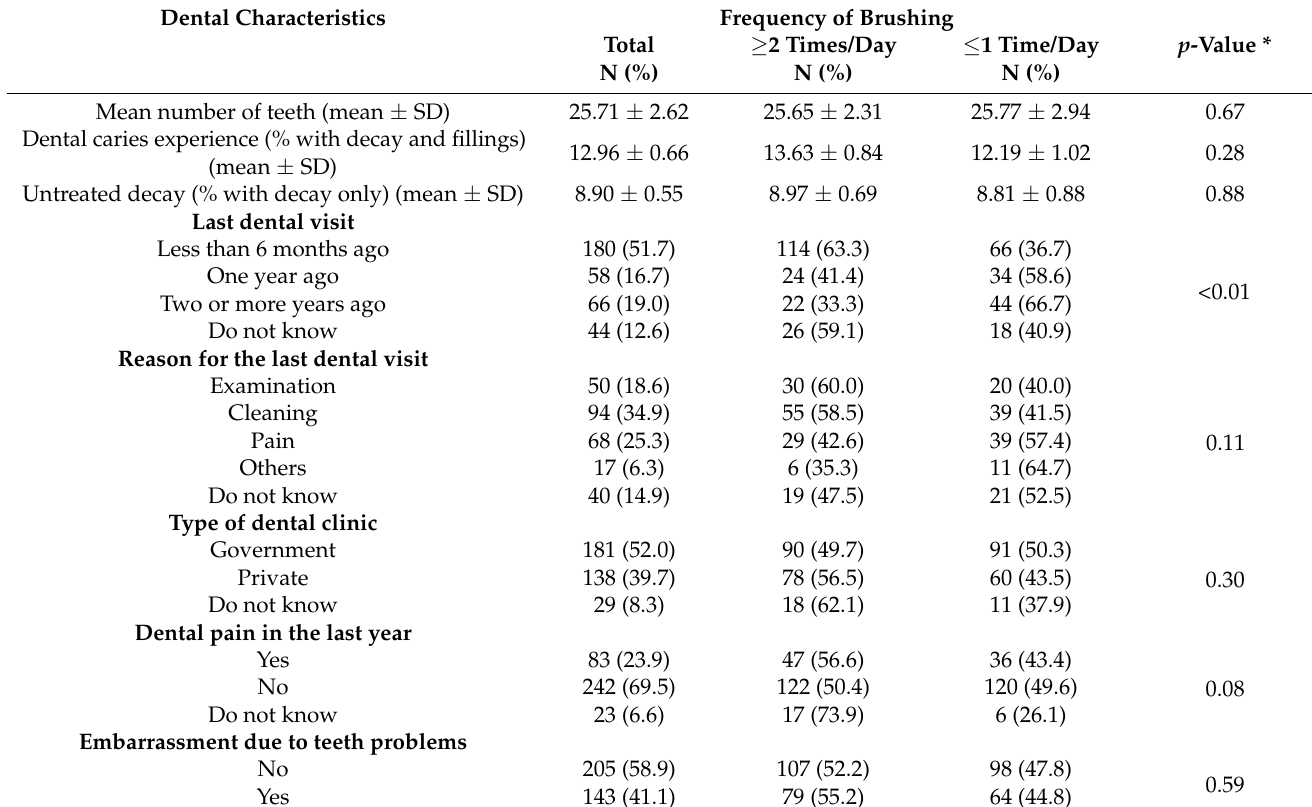
Table 2. Dental characteristics of the participants in relation to frequency of toothbrushing.